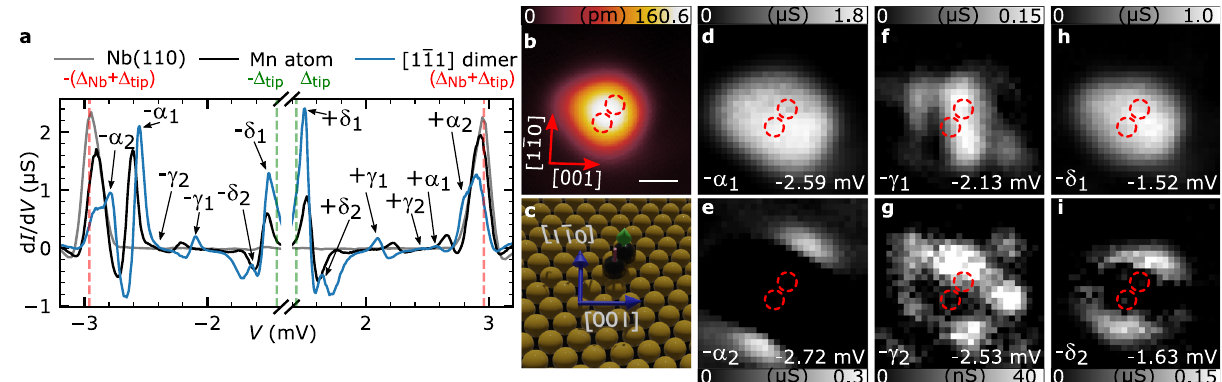
ffiffiffi p -- a = 2 (cid:3) ½ 1 3 11 (cid:2) Mn dimer. a d I /d V spectrum taken between the two atoms of a ffiffiffi p a = 2 (cid:3) ½ 1 (cid:1) 11 (cid:2) Mn dimer. The white scale bar has a length of 500 pm and also applies to panels 3